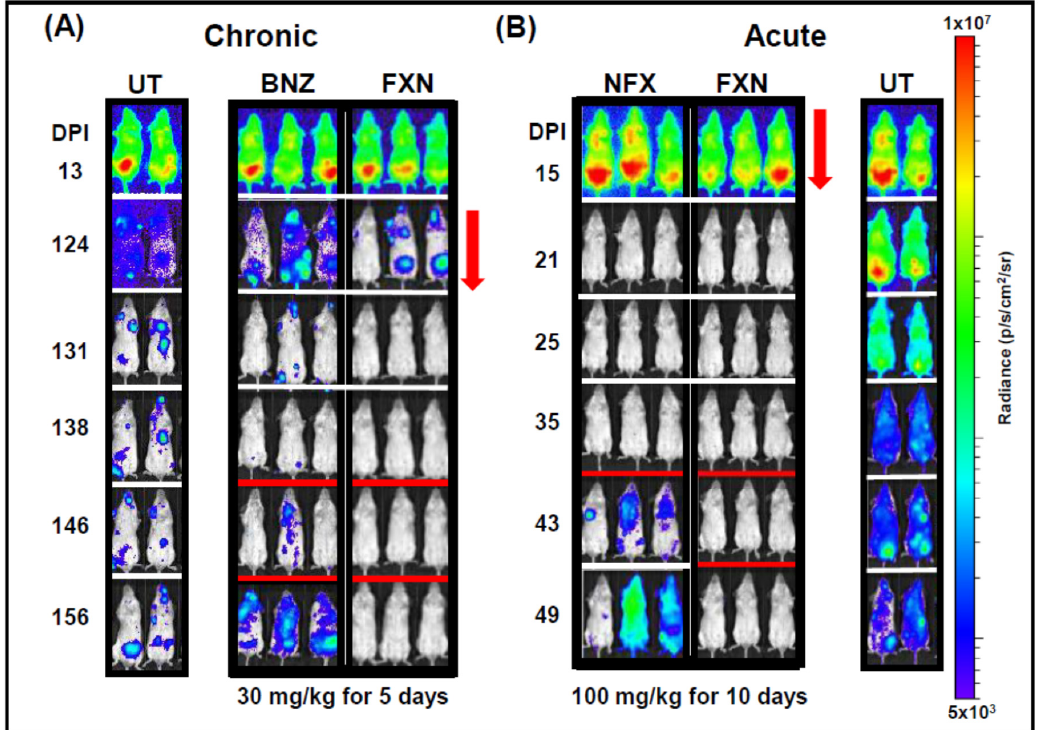
Figure 2. Fexinidazole outperforms benznidazole and nifurtimox as a treatment for experimental Trypanosoma cruzi infections. ( A ) BALB/c mice were infected with bioluminescent T. cruzi CL Brener strain [99]. At the chronic stage of infection (124 days), they were treated with benznidazole (BNZ) or fexinidazole (FXN) (30 mg/kg, orally, once daily) for 5 days (marked by red arrow). Treated mice were immunosuppressed on days 138, 142 and 146 using cyclophosphamide (200 mg/kg, i.p) (red lines). Images were acquired using the Lumina II IVIS system (Caliper Life Science) [100]. ( B ) BALB/c mice at the acute stage of infection (15 days) were treated with nifurtimox (NFX) or FXN (100 mg/kg, orally, once daily) for 10 days (red arrow), and then immunosuppressed on days 35, 39 and 43 using cyclophosphamide (red line). UT, untreated control mice. Heat-maps are on log10 scales and indicate intensity of bioluminescence from low (blue) to high (red). Full data set available in reference [34].